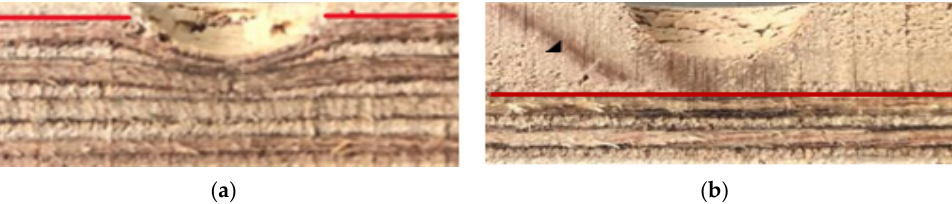
Figure 11. Cross sections of tested engineered flooring with red line showing the top layer boundary, (( a ): veneer prototype with both top layer and substrate penetrated ( b ): indentation only observed in 6 mm thick top layer).